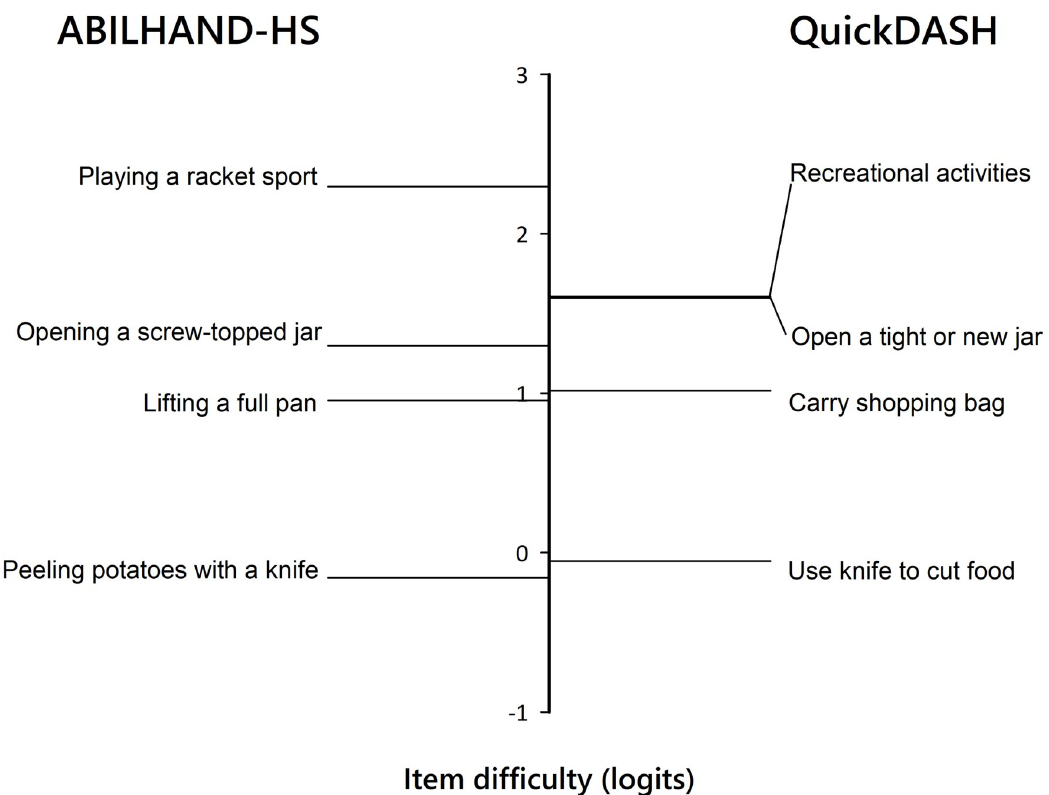
Fig 4. Comparison of difficulty levels (vertical axis) between similar items of the ABILHAND-HS (left) and QuickDASH (right) scales. QuickDASH item responses were added to the anchored data matrix of ABILHAND-HS responses to equate both